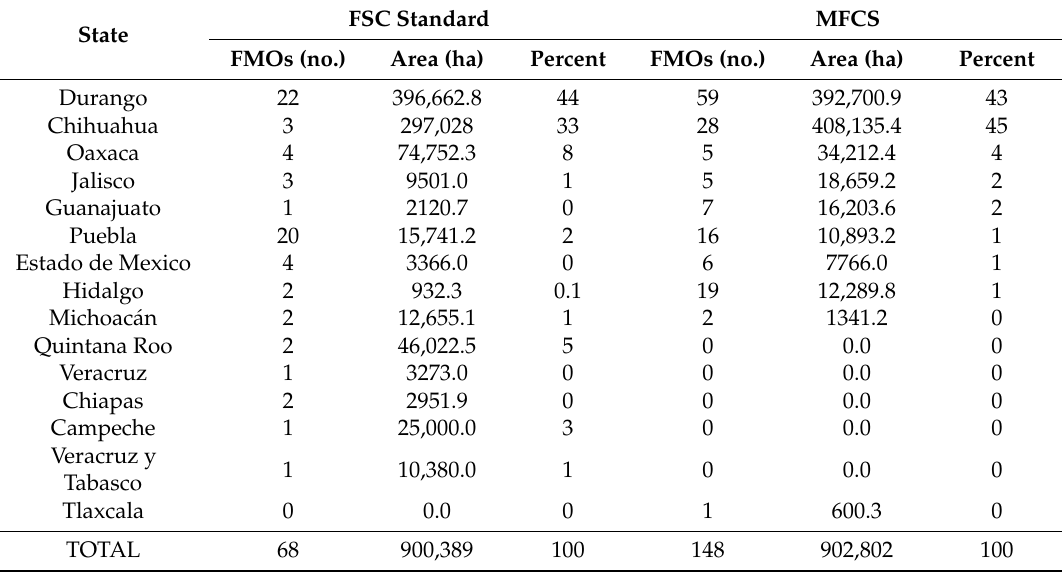
TOTAL 68 900,389 100